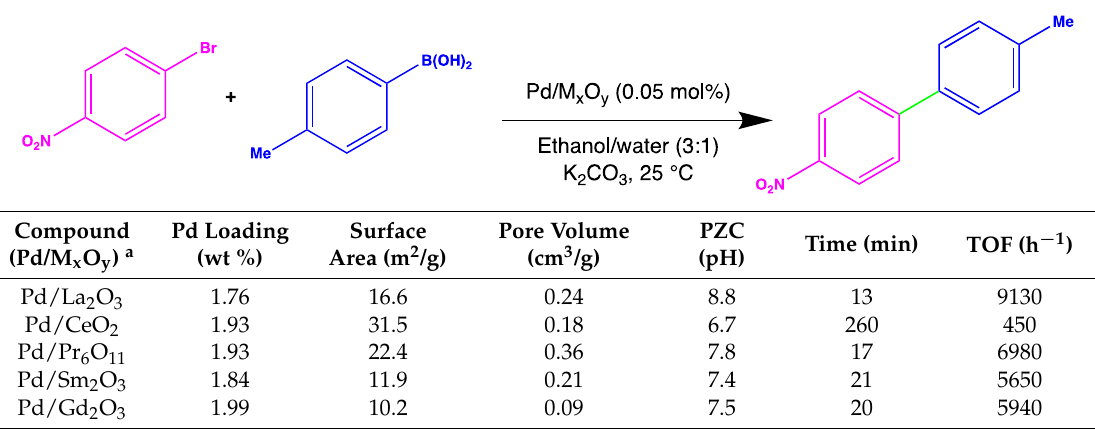
Table 3. The physicochemical properties of the synthesised Pd/M x O y based catalysts and their catalytic activity results [10] (Adapted with permission from Springer Nature).